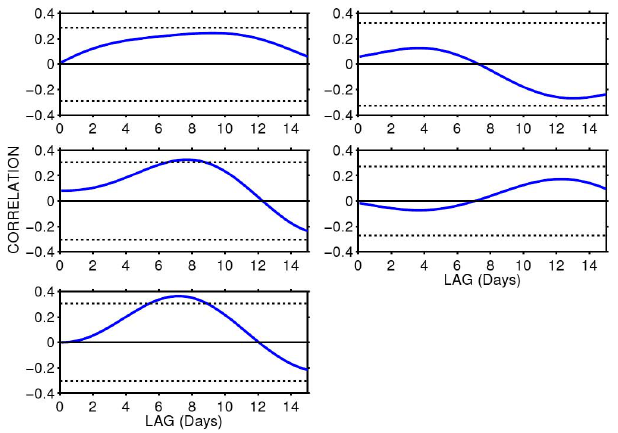
Fig. 18. Correlations (with time lags applied to the UFKW in the MLT) between E1 waves of period 2.5–4.5 days in the Aura analysis at a height of 97km and similar oscillations in the TRMM analysis, from 2005 (top left) to 2010 (bottom right). The dashed lines on the figures indicate the 95% confidence